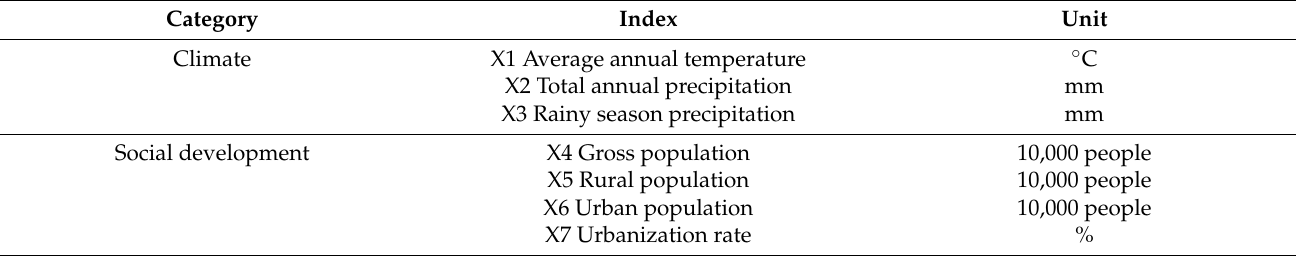
Table 2. Indicators and their categories of economic and social development